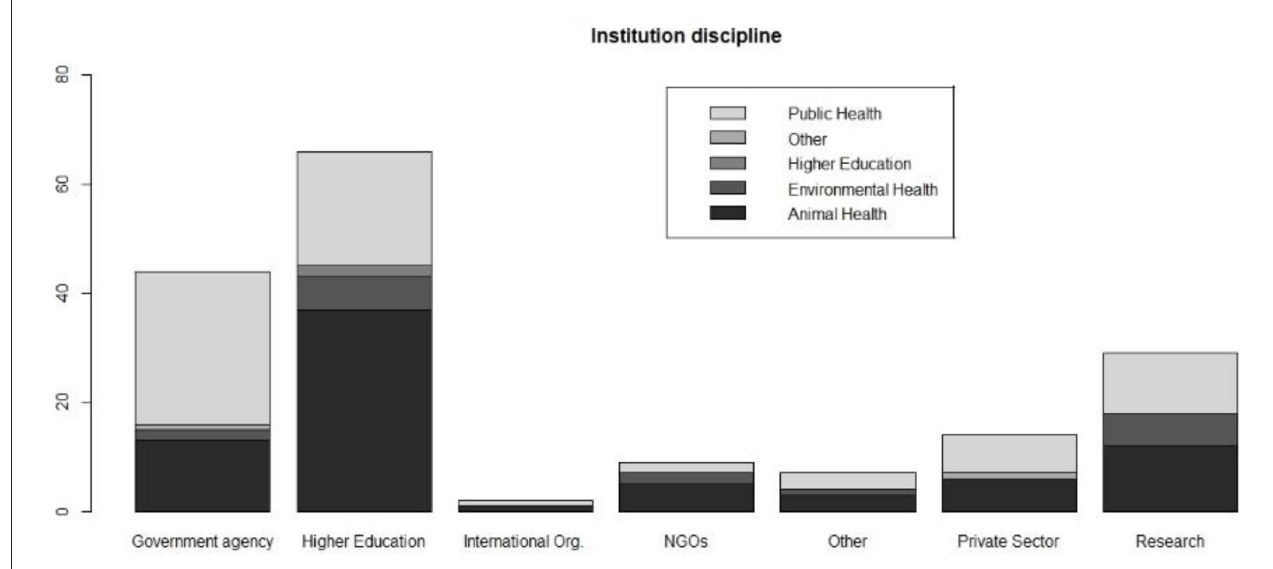
FIGURE 2 | Type of institution and sector where respondents are